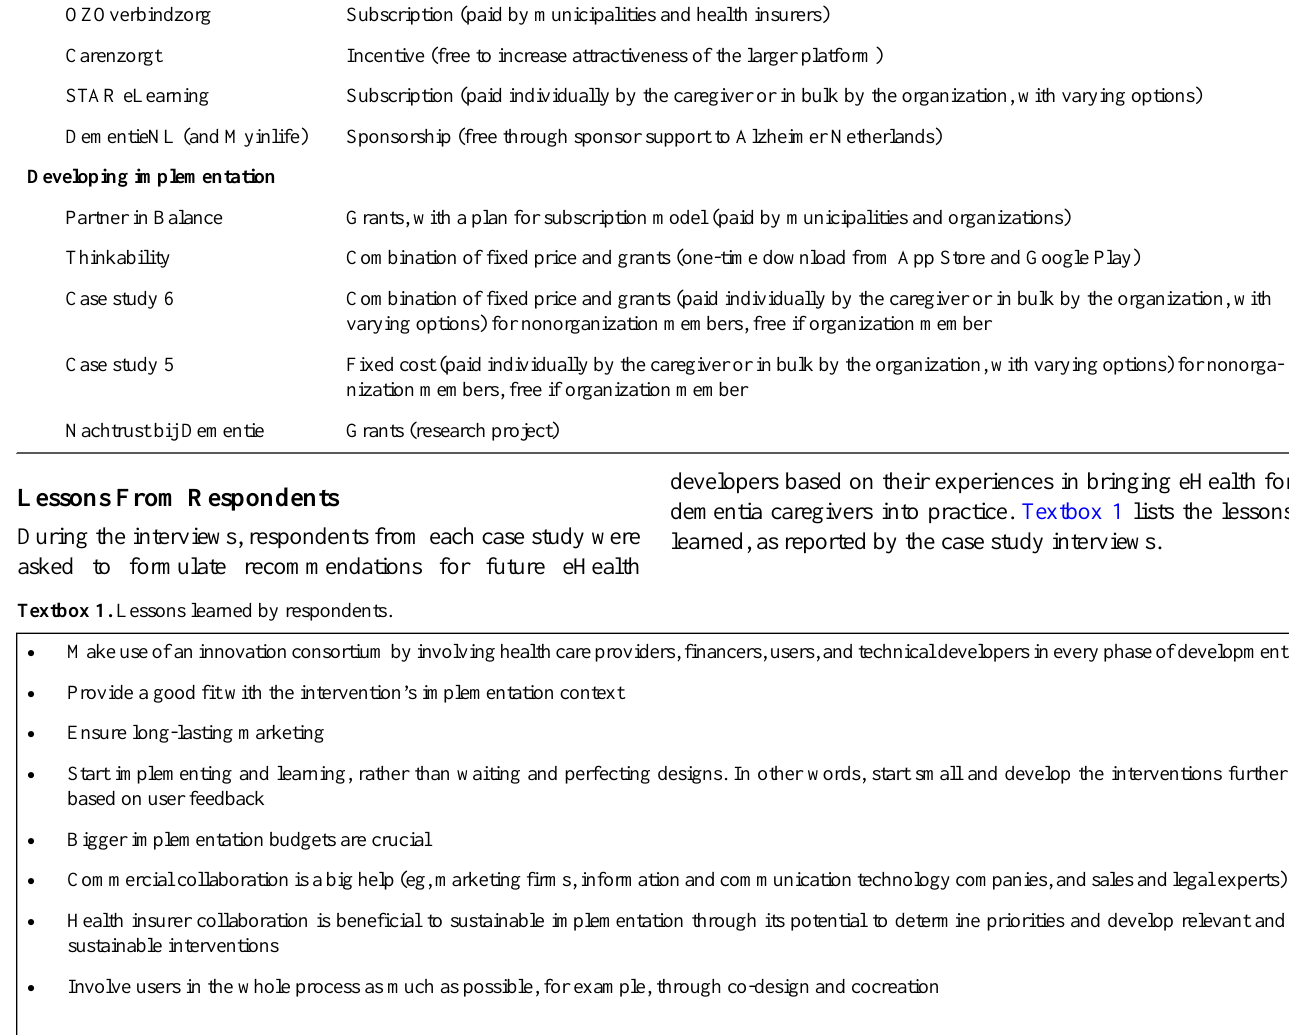
Table 4. Implementation phase and business models of the case studies. Sustainable